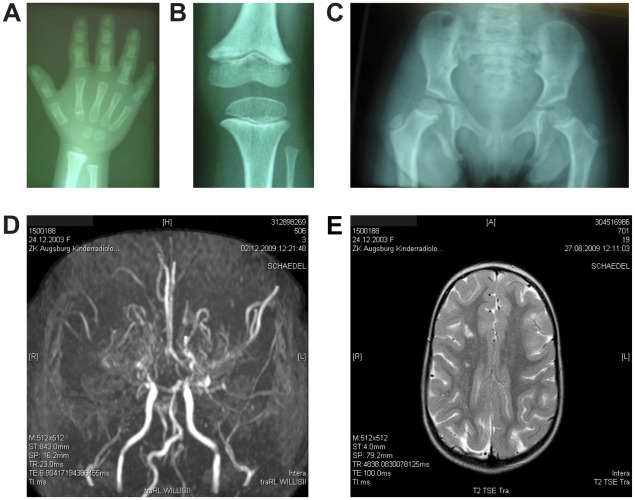
Radiological examinations and neuroimaging.A, Left hand at the age of 4.1 years: mild metaphyseal flaring of distal radius and ulna; shortening of the distal ulna; short metacarpal I; pseudoepiphyses of metacarpals II and V, shortness of the middle and distal phalanges; clinodactyly of the little finger, bone age was retarded (11 months). B, Left knee at the age of 5.7 years: V-shaped flare of the distal femoral metaphyses; triangular shape of the distal femoral epiphyses. C, Hip at the age of 5.7 years: high and narrow pelvis with broad cranial parts of the ischia; irregular metaphyses of the proximal femur; coxa vara. D, Brain MRI at the age of 5.9 years: bilateral occlusion of the intracranial internal carotid artery and the middle cerebral arteries and occlusion of the right anterior cerebral artery, prominent moyamoya collaterals; E, Brain MRI at the age of 5.7 years: old infarcts in the right white matter region.